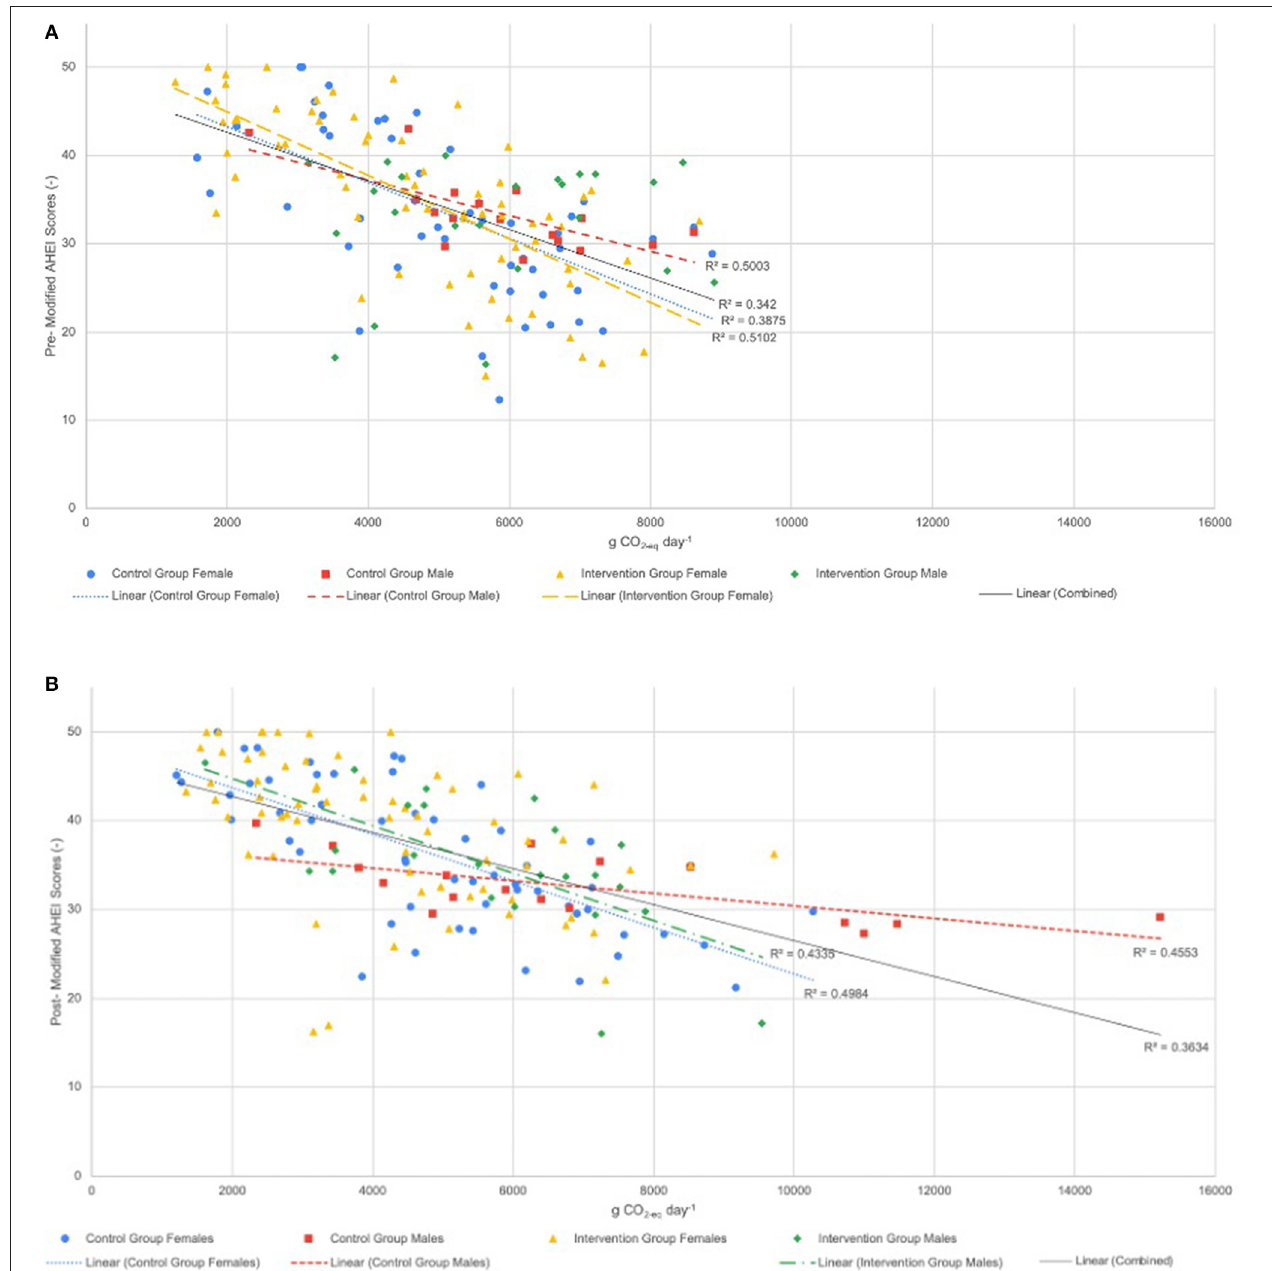
FIGURE 7 | Relationship between a 50-point modified Alternative Healthy Eating Index and greenhouse gases for student diets at baseline (A) and follow up (B) .